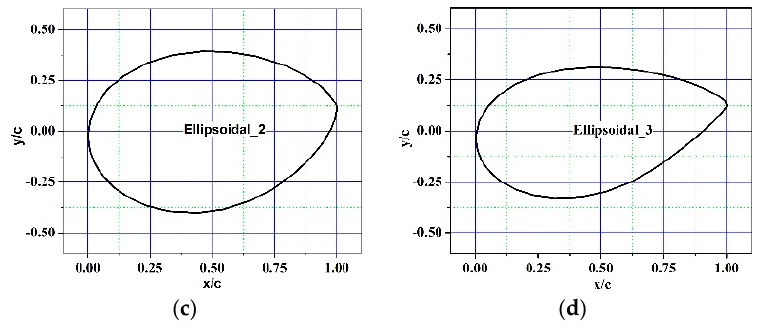
Figure 6. Root aerofoil geometry, from blade root to tip in the order of ( a – d ), respectively.